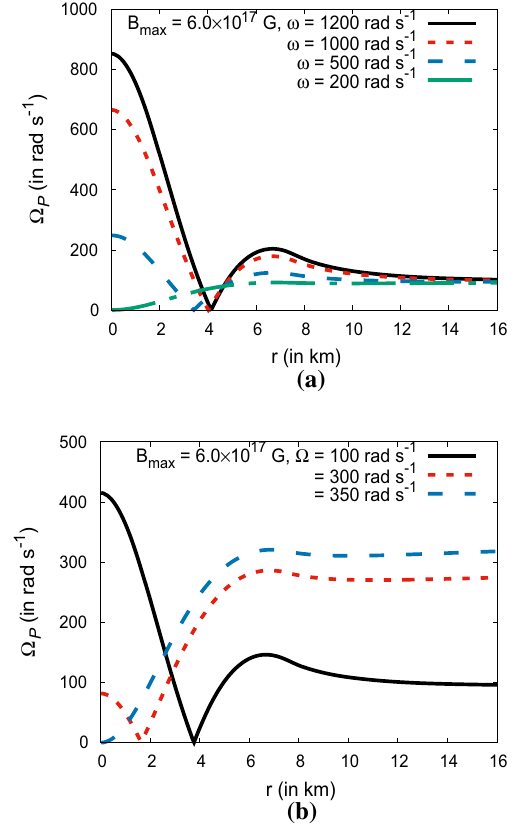
Fig. 25 a Ω P of the gyro around a rotating and magnetized NS with different values of B . Here ω = 700 rad s − 1 . The black solid line is for the highest magnetic field strength. The red short dashed curve is for a moderate field strength. The blue dashed line is for comparatively lesser strength. The value of Ω is taken to be 100 rad s − 1 . b Similar curve with only ω = 215 rad s −